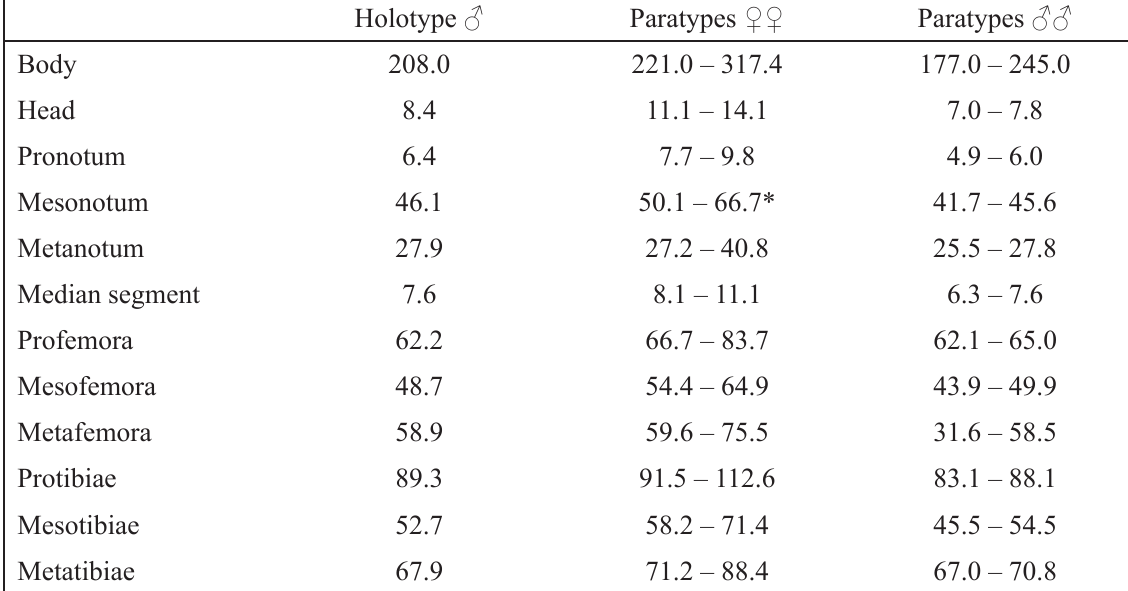
Table 3. Measurements (mm) of Phryganistria heusii yentuensis subsp.